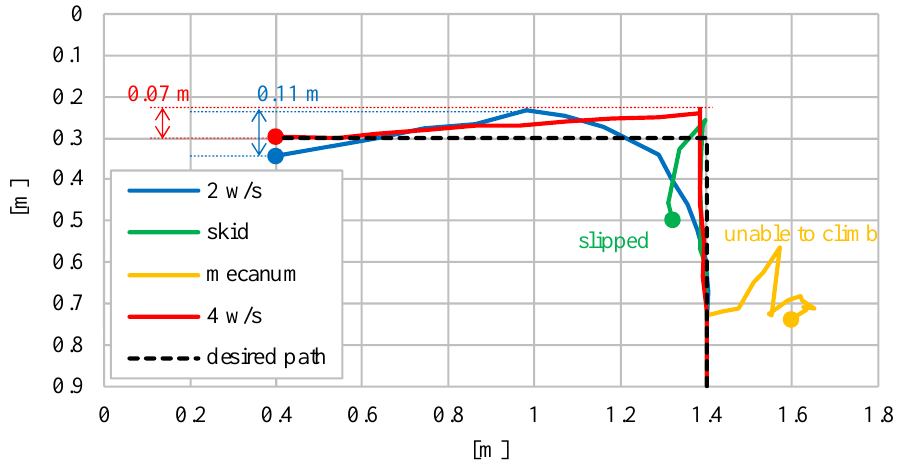
Figure 8. Path from the basic experiment with four types of steering methods.